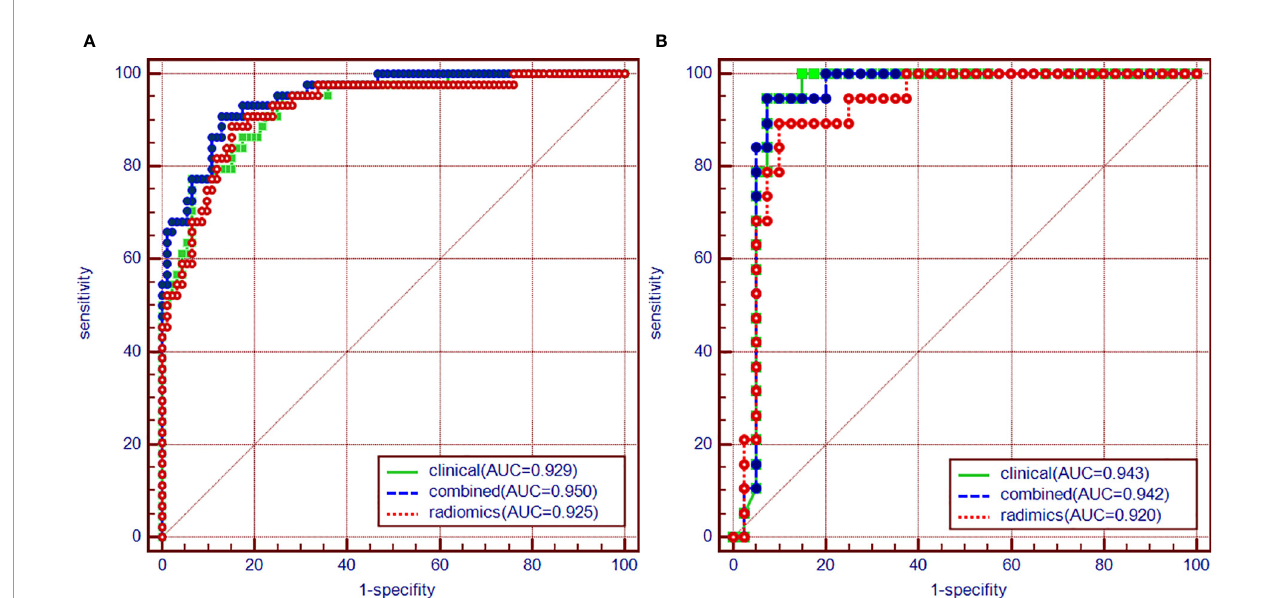
FIGURE 3 | (A) Diagnostic ef fi ciency of3 modelsusing ROC analysisin the training cohort. (B) Diagnosticef fi ciency of 3 modelsusingROC analysis inthe testing